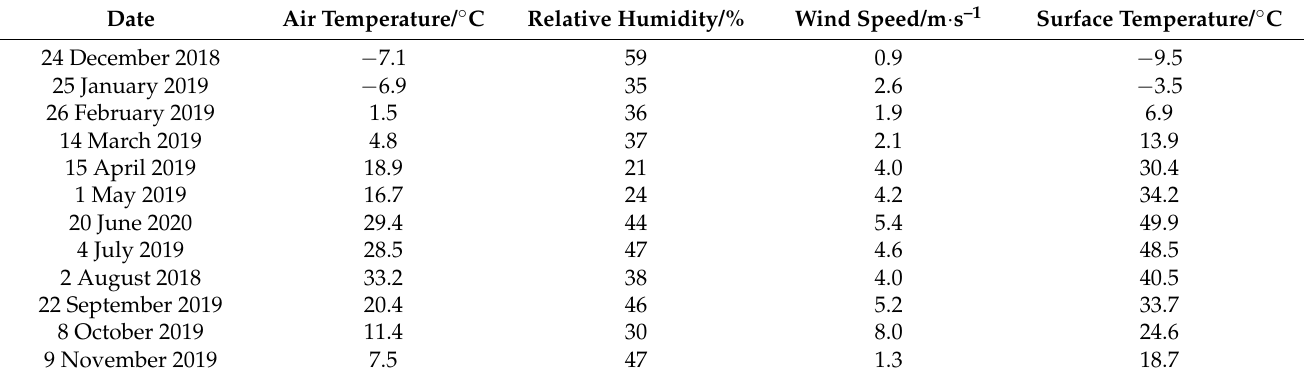
Table 1. Date list and weather conditions in different months corresponding to 12 thermal-infrared